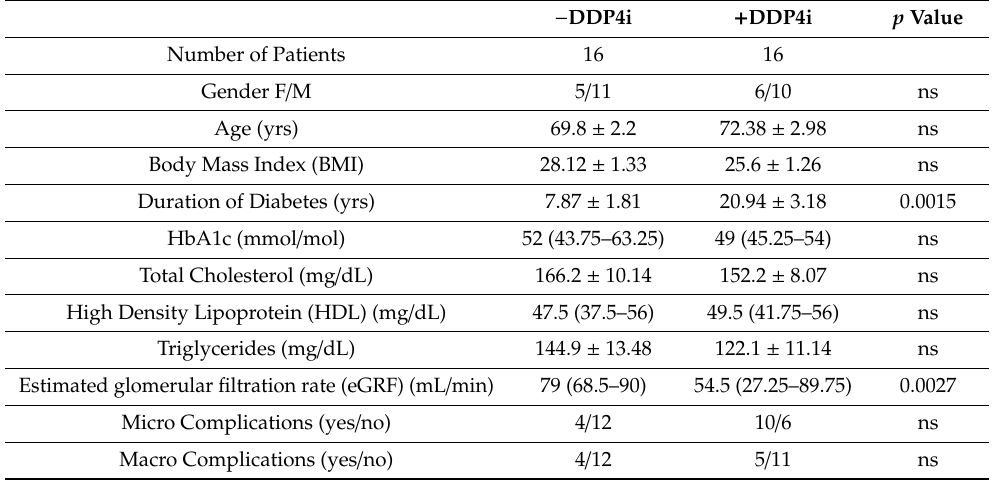
Table 1. Demographic and clinical characteristics of the study groups after propensity score matching.